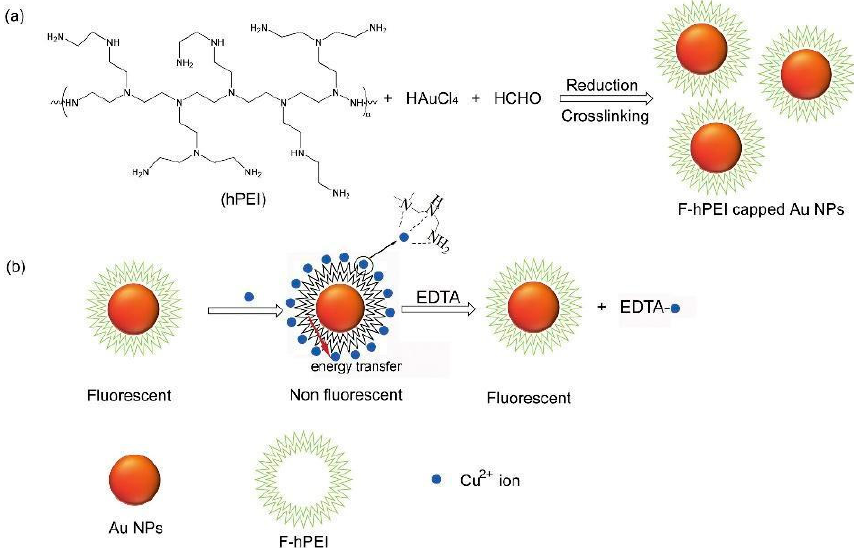
Figure 4. Proposed ( a ) reaction mechanism and ( b ) fluorescence quenched and recovered mechanism for the Cu (II) ion sensor based on F-hPEI capped AuNPs. (Reprinted from reference [88] with permission of Elsevier).